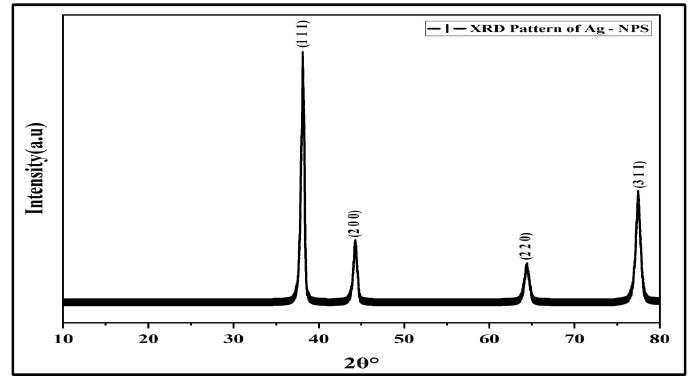
Figure 3. XRD pattern of AgNPs.